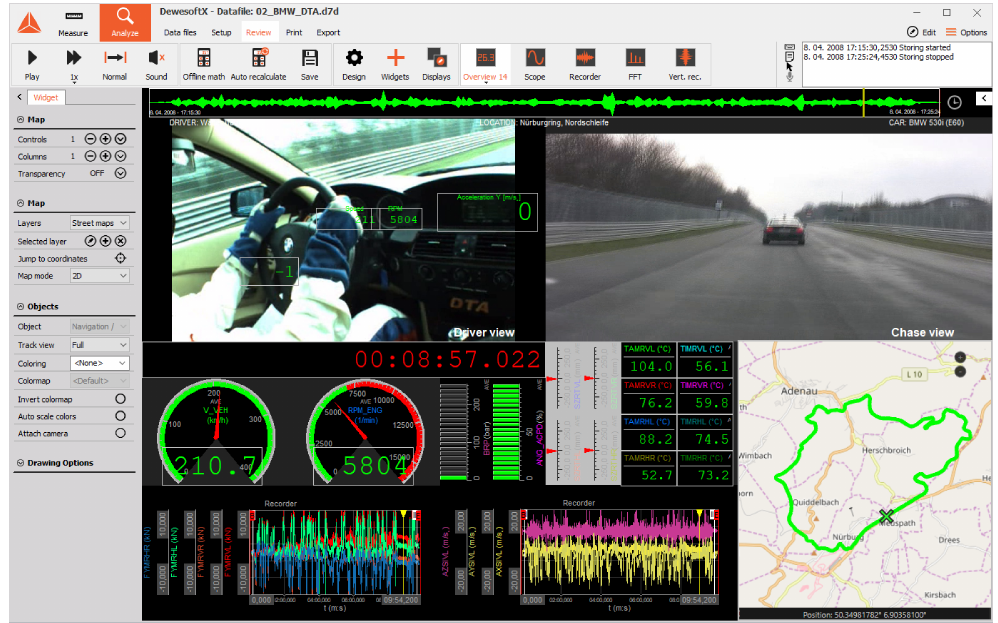
Figure 1. Measurement system Dewesoft, as observed by the testing